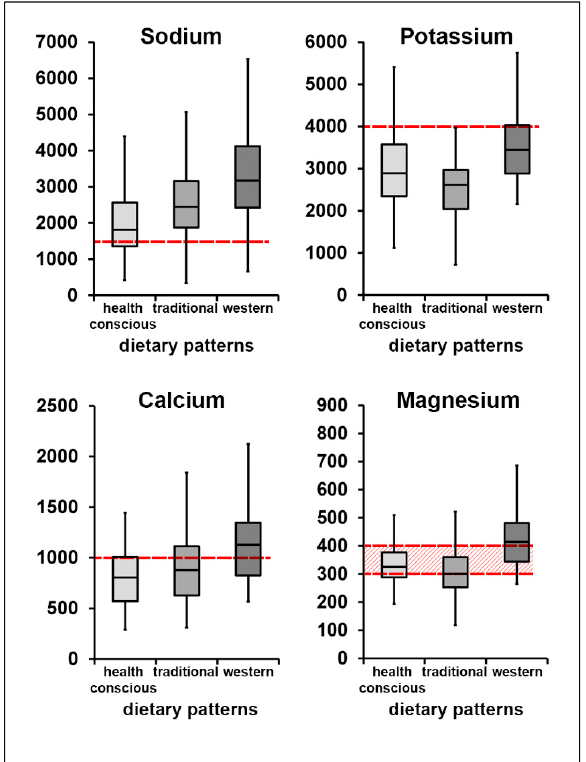
Figure 5. Median intake levels of electrolytes in different dietary patterns in mg/day. Red dashed lines depict recommended intake levels for each electrolyte. For magnesium, the red dashed pattern shows distribution of reference values for different gender/age groups.